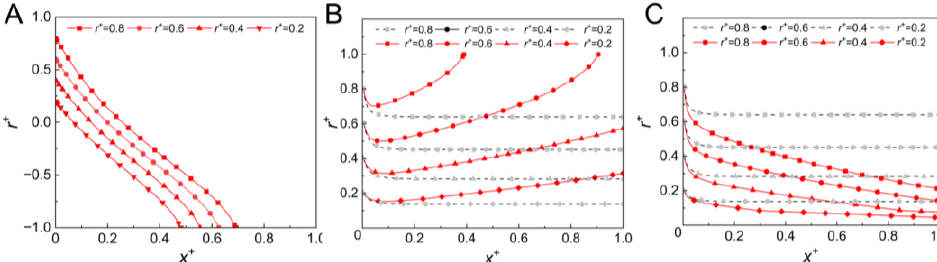
Figure 4. Particle trajectory with the external force of 5 × 10 − 10 N (in red color) and without the external force (in gray color): ( A ) the external force was in the direction perpendicular to the gas flow; ( B ) the external force was in the same direction as the gas flow (the +x direction); ( C ) the external force was in the direction reverse to the gas flow (the − x direction) (particles were released from r + = 0.2, 0.4, 0.6, 0.8, respectively; u = 10 m/s, d p = 1 μm, ρ p = 1550 kg/m 3 ).